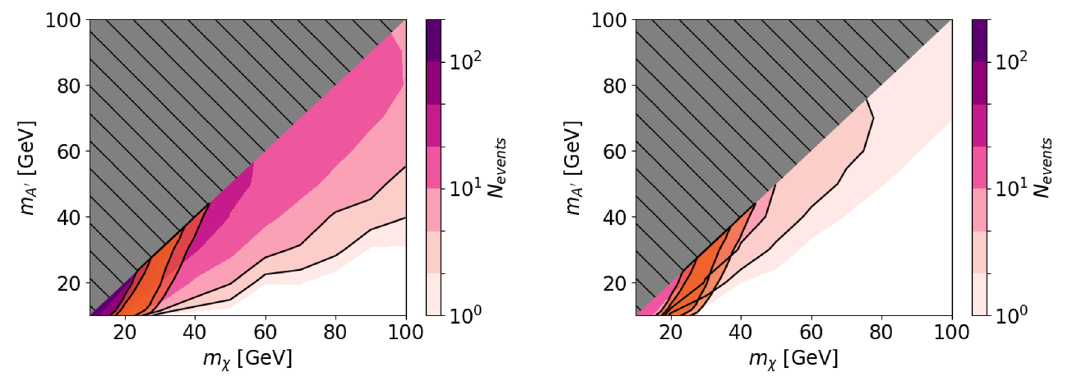
Figure 10. Similar to (cid:12)gure 9, the expected number of events observable by GAPS for the DPDM model in a modi(cid:12)ed NFW with (cid:13) = 1 : 26 assuming MAX (left) and MED (right) cosmic ray propagation. The region favored by the GCE measurement is highlighted and taken from